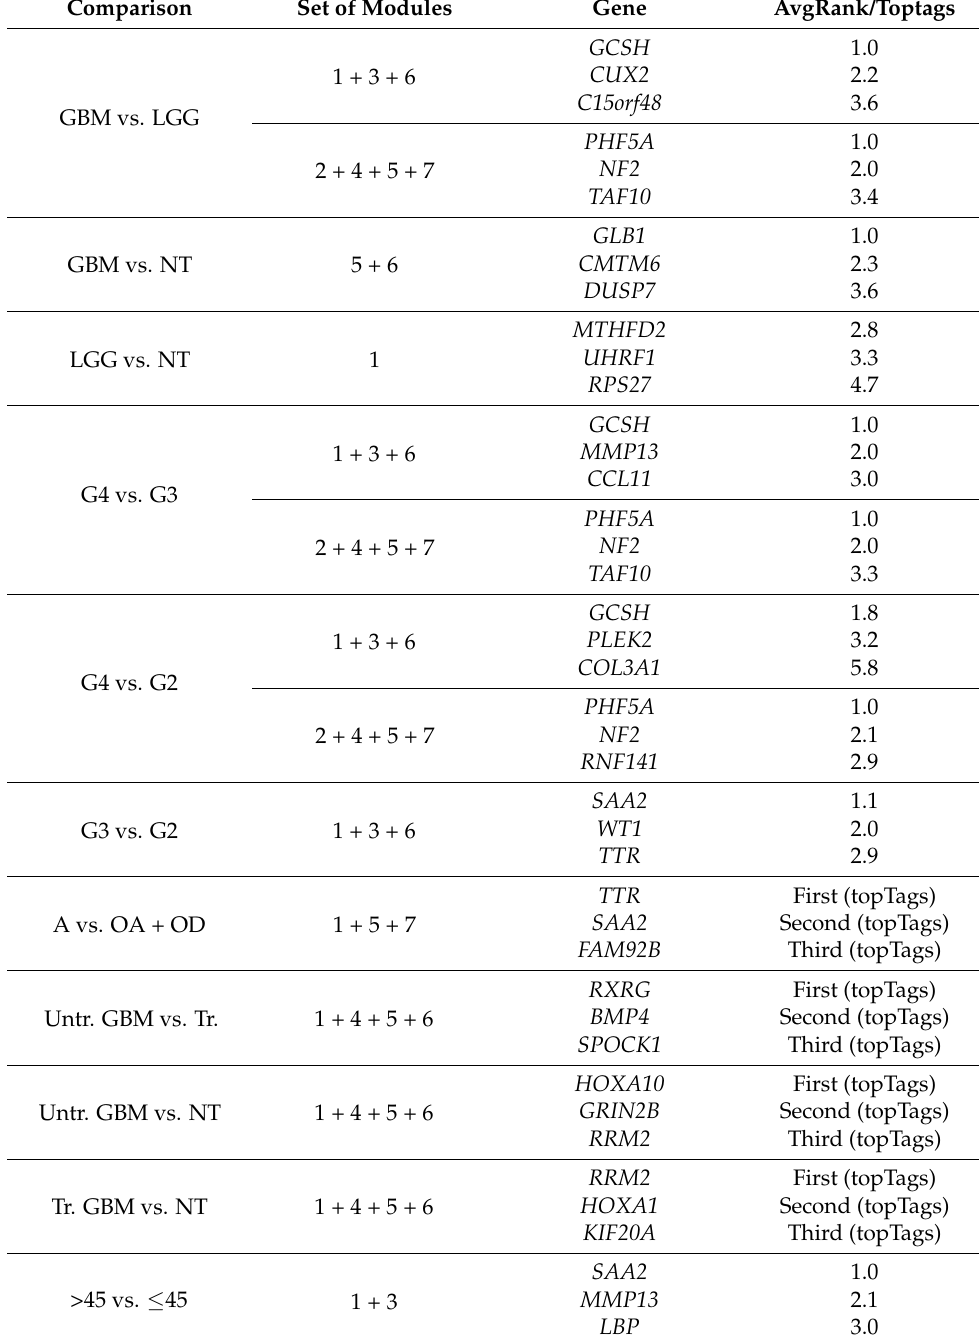
Table 1. The most relevant DEGs of each comparison appraised by mSVM-RFE or topTags(). Comparison Set of Modules